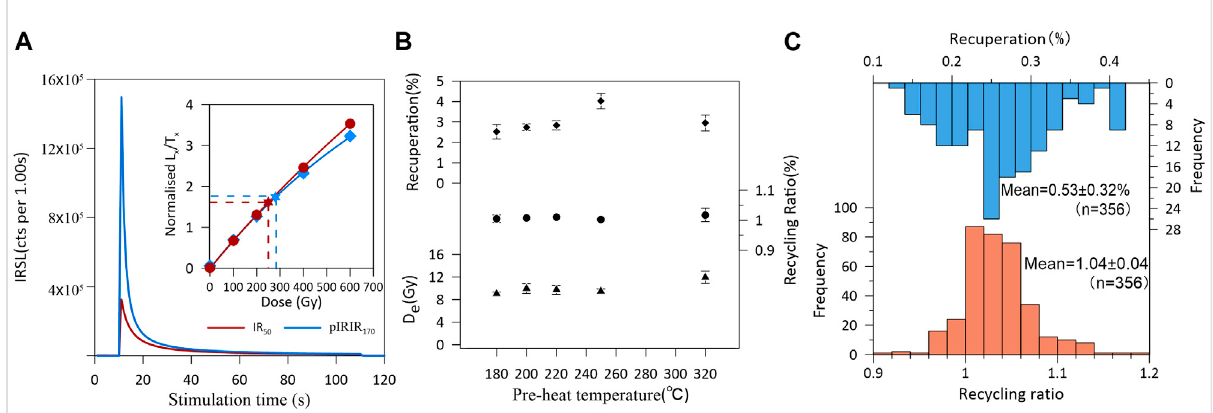
FIGURE 4 (A) Typical IR 50 and pIRIR 170 decay curves and corresponding growth curves (inset) from a representative sample (LGN-286); (B) D e plateau of pIRIRsignalsatdifferentpreheatandstimulationtemperaturesforsampleLGN-302; (C) summarizedrecuperation(top)andrecyclingratios(bottom) of pIRIR 170 signal from all 49